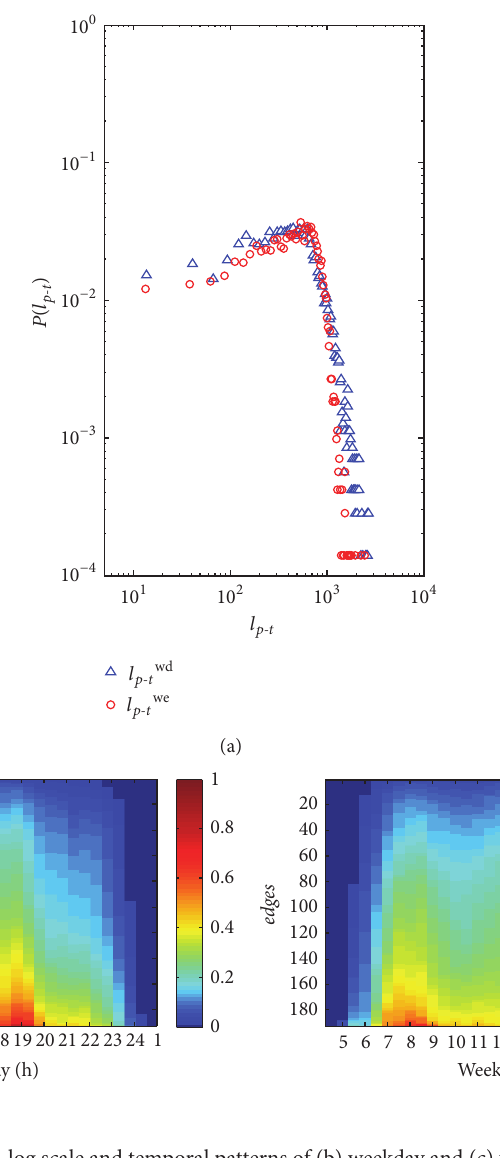
Figure 7: Real load (a) distributions on log-log scale and temporal patterns of (b) weekday and (c) weekend. In (a), the real loads 𝑙 𝑝 we can be fitted by power law fits with exponents 0.55 and 0.56, respectively. The 𝑅 2 are all 𝑙 𝑝 - 𝑡